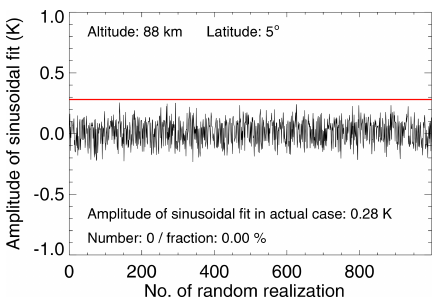
Figure 8. Illustration of the Monte Carlo significance test for an altitude of 88km and a latitude of 5 ◦ N. The red line shows the am- plitude of a sinusoidal fit to the extracted 27d signatures in MLS daily averaged temperature. The black line shows the fitted ampli- tudes to epoch-averaged temperature anomalies for 1000 randomly chosen epoch ensembles.